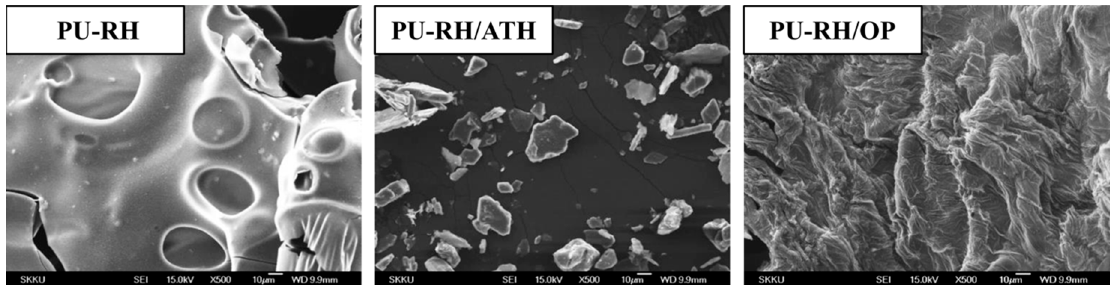
10 of 17 Figure 6. Cone calorimetry results for PU–RH, PU–RH/ATH, and PU–RH/OP. The FTIR spectra (Figure S2) of the PU–RH char show the absorption bands of N–H (3564 cm -1 ), O–H (3355 cm -1 ), Si–O (1106 cm -1 ), and Si–OH (832 cm -1 ). The FTIR spectra of the PU–RH/ATH and PU–RH/OP residues show an additional band of Al–O (668 cm -1 ) related to the aluminum oxide/aluminum phosphate in the ATH- and OP-decomposed structures. Moreover, the peaks at 1613 and 1090 cm -1 are attributed to the P–OH and P–O stretching bands in PU–RH/OP, respectively. These findings further confirm the FR abilities of the ATH and OP in the formation of the char layers. These layers could function as a barrier inhibiting the thermal and oxygen transport and preventing the inner side of the materials from the direct exposure to the heat and combustion zone. The morphologies of the charred residues of PU–RH, PU–RH/ATH, and PU–RH/OP are